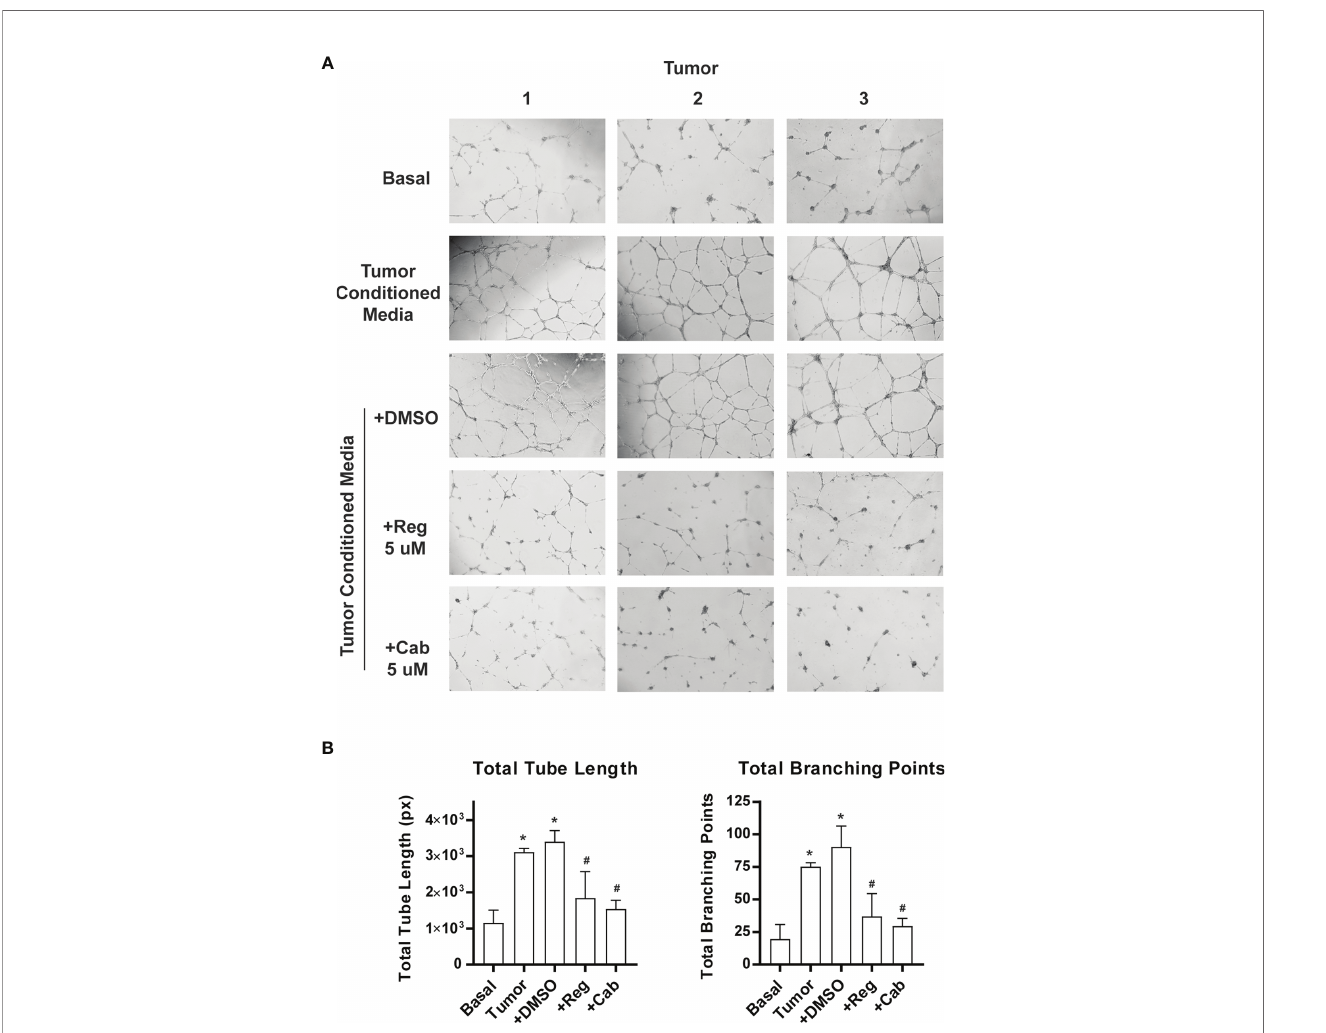
FIGURE 7 | Inhibition of pituitary tumor angiogenesis by VEGF receptor inhibitors. Angiogenesis was assayed by endothelial cell tube formation in Matrigel gel. The pictures were analyzed by WimTube online program. (A) A sample picture used for analysis by WimTube. (B) Tube formation is presented as total tube length ( left panel ) and total branching points ( right panel ) per fi eld. The values are mean ± SD of experiments with three NFAs. *p < 0.05 vs basal medium; #p < 0.05 vs treatment with conditioned